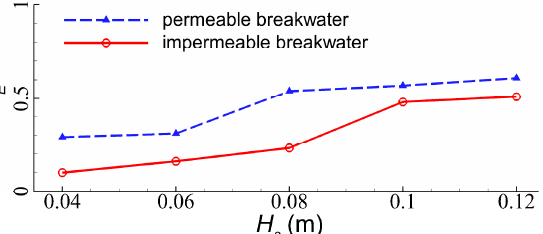
Figure 15. Variations in the total wave energy dissipation rate with the significant wave height.